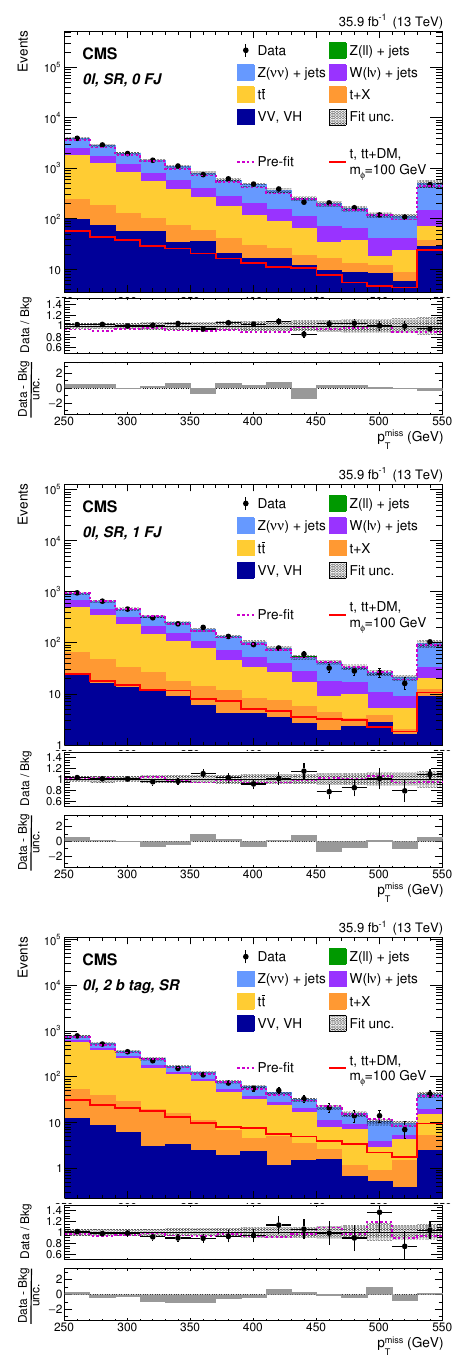
Figure 5 . Background-only post-(cid:12)t p miss distributions for the SRs of the AH selection. The total T theory signal (t = t+DM and tt+DM summed together) is presented by the red solid lines for a scalar mediator mass of 100 GeV. The last bin contains over(cid:13)ow events. The dashed magenta lines show the total pre-(cid:12)t background expectation in the upper panels, and the ratio of pre-(cid:12)t total background to post-(cid:12)t total background in the middle panels. The lower panels show the di(cid:11)erence between observed and post-(cid:12)t total background divided by the full statistical and systematic uncertainties.